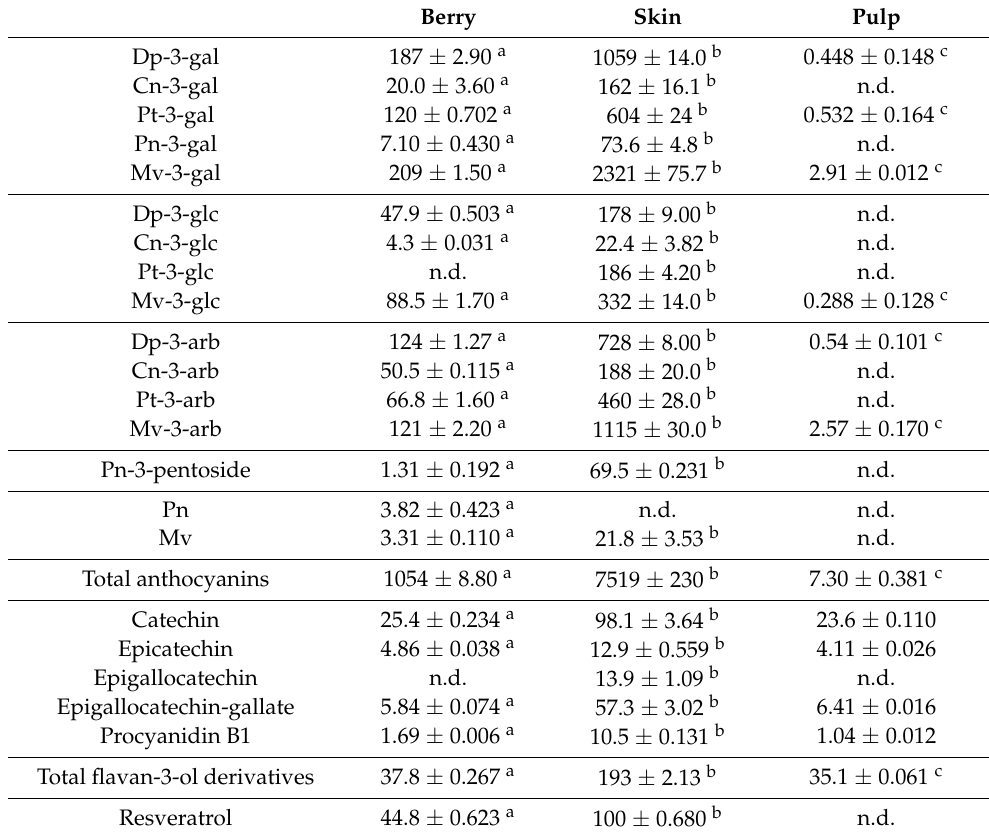
Table 1. Flavonoid contents (mg/100 g d.m.) and resveratrol in berry, skin and pulp of Windsor blueberry (means, standard deviations and homogenous groups). Berry Skin